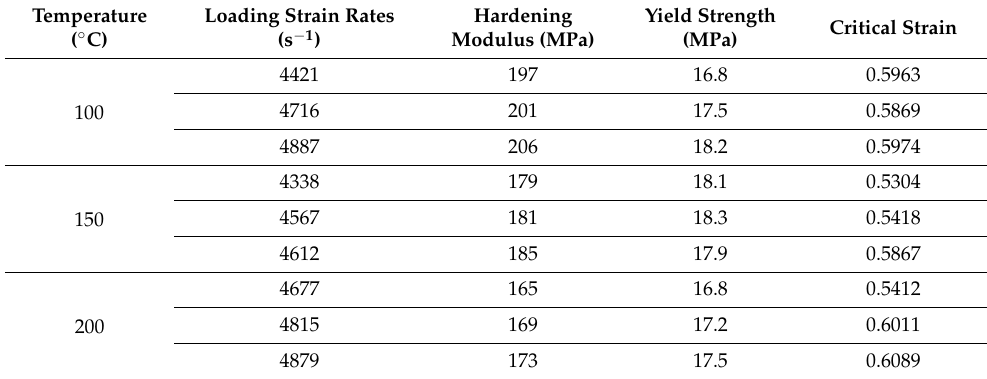
Figure 13. The true stress − strain relationship curve of the PTFE/Al/Si reactive material at different temperatures: ( a ) T = 100 °C; ( b ) T = 150 °C; ( c ) T = 200 °C. Table 6. The main dynamic performance parameters of PTFE/Al/Si reactive material at different temperatures.